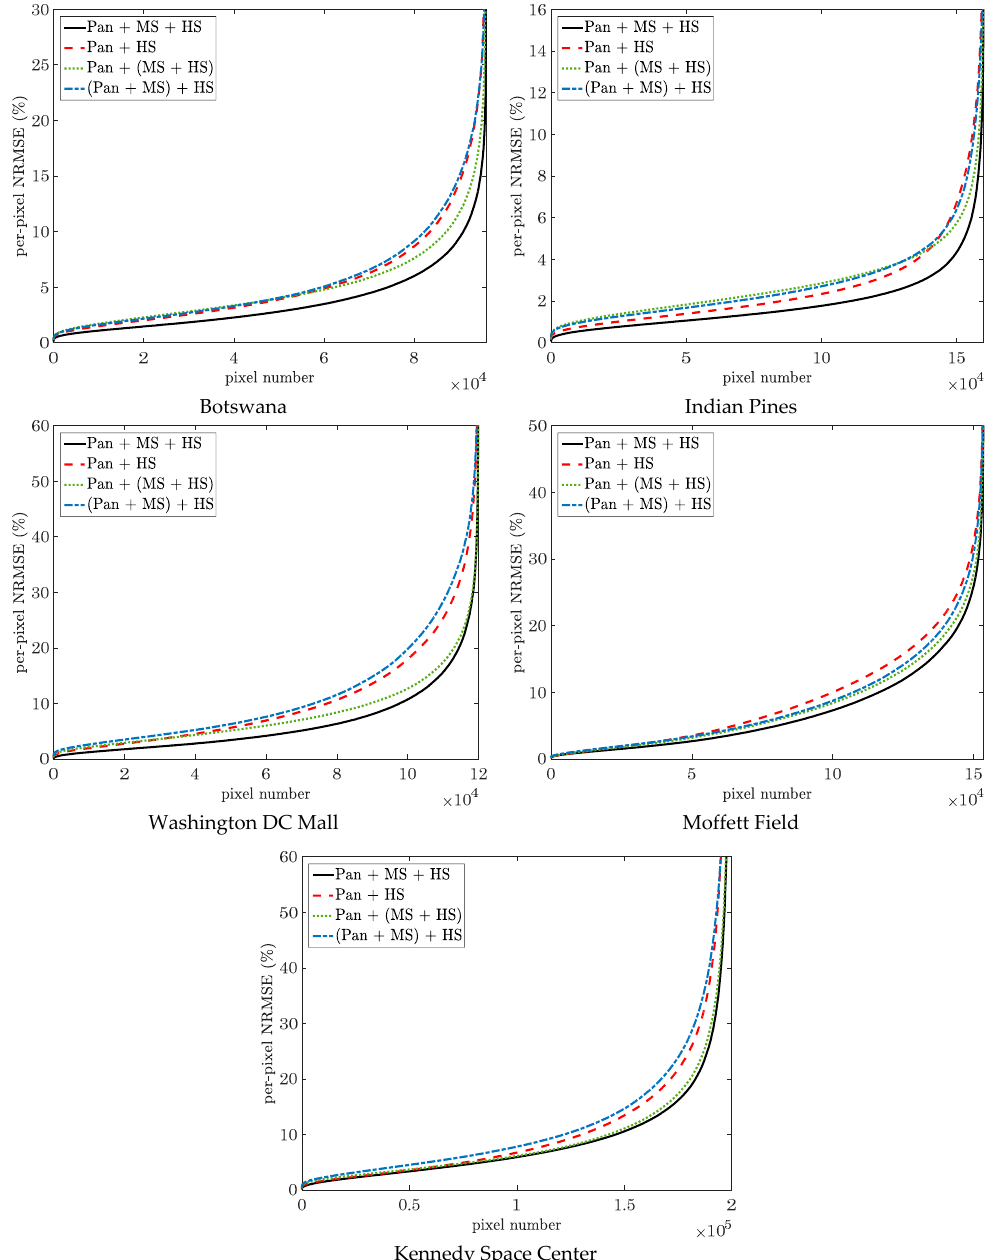
Figure 5. The sorted per-pixel NRMSE of different algorithms measured on the entire spectrum in experiments with different images.